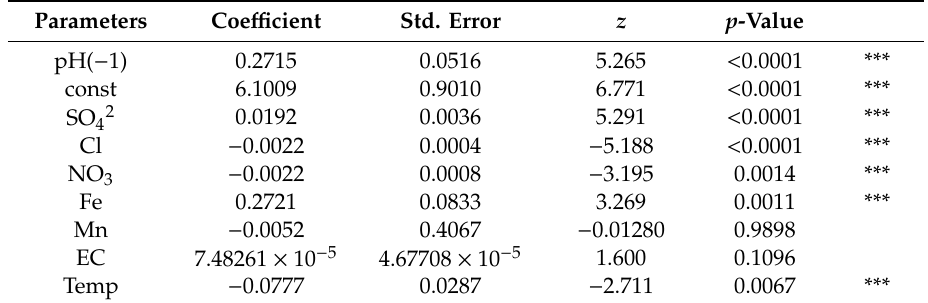
Table 2. Multiple regression statistical model with dependent variables against the pH as independent variables for selected wet season hydrochemical